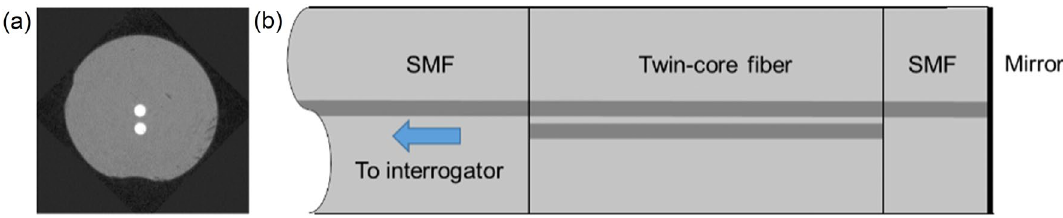
Figure 2. ( a ) Cross-section of the 125 µm TCF used in this work. ( b ) Schematic of the sensor head comprising a section of TCF and a short piece of mirrored single-mode fiber.